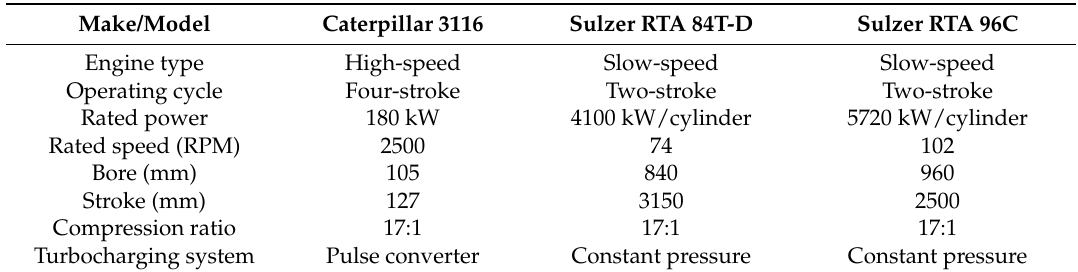
Table 1. Specifications of test engines selected for